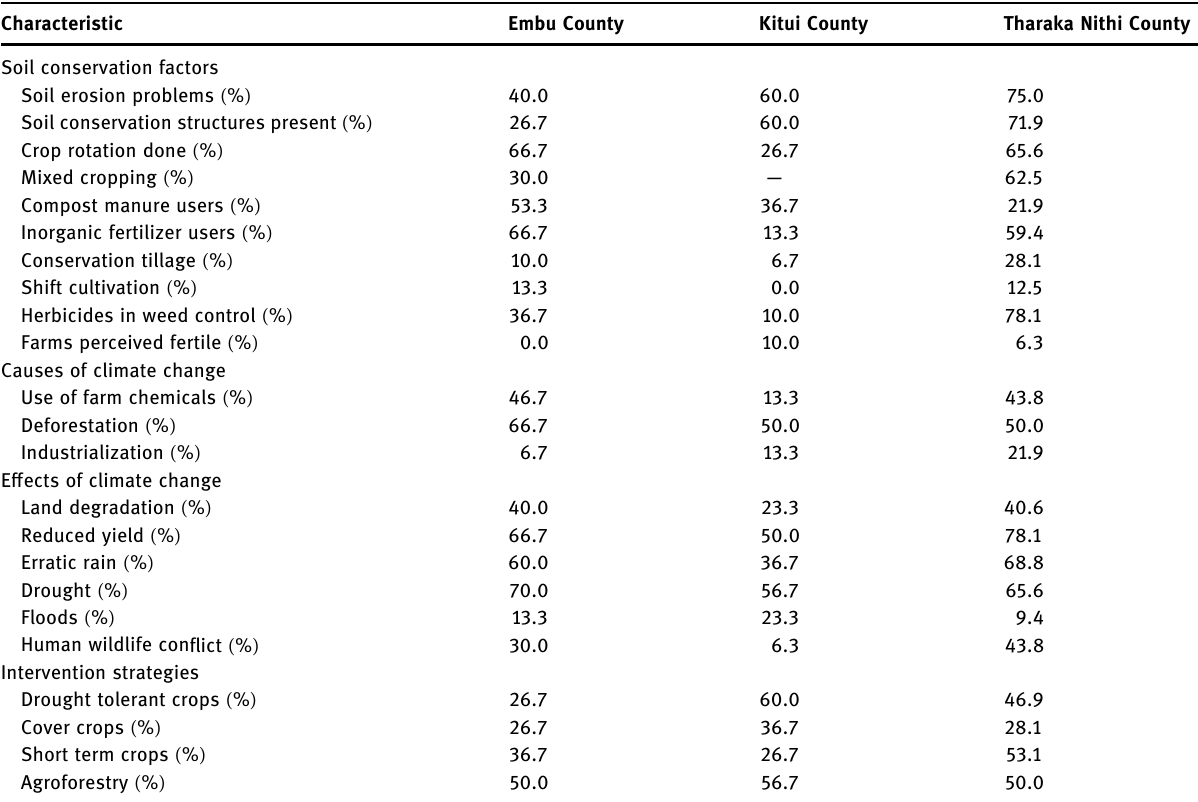
Table 4: Soil conservation status and climate change perception